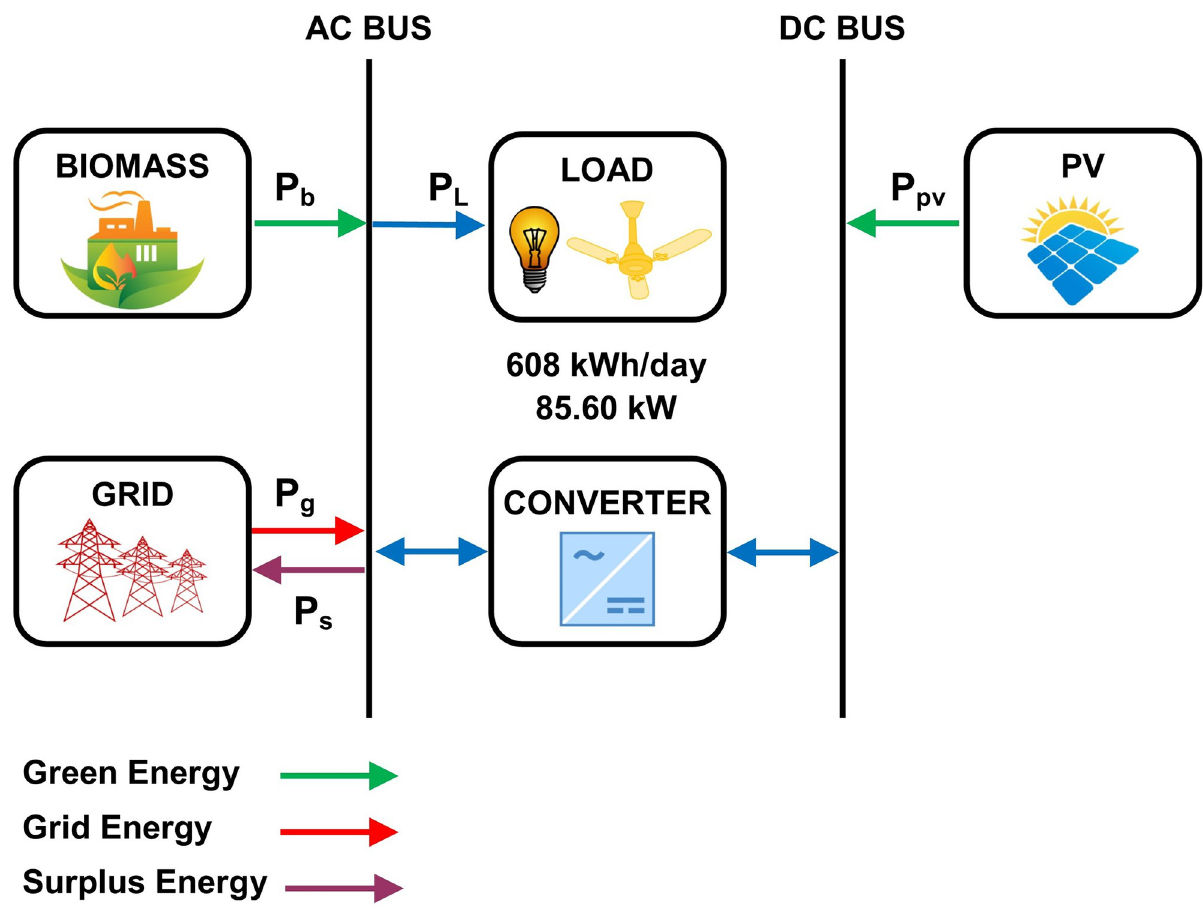
Fig 6. The hybrid energy model-C for the prosumer community.